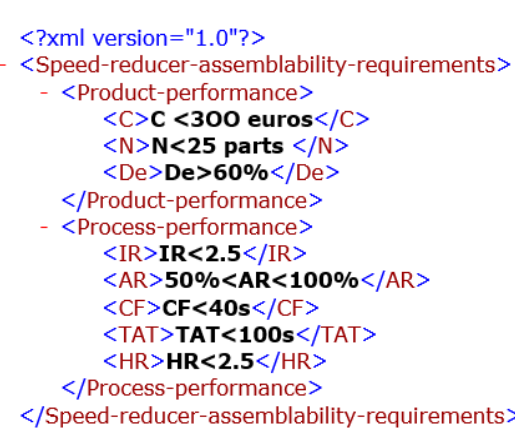
Figure 6. Generation of functional requirement data in XML format .